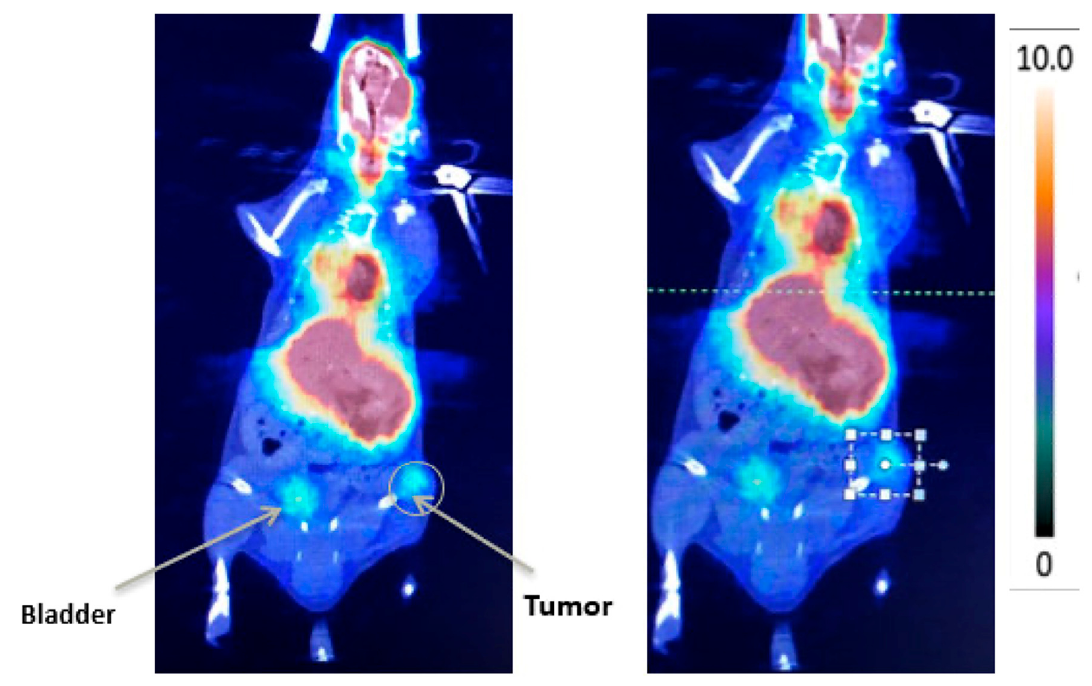
Figure 1. 68Ga-PSMA PET / CT images showing tumor recurrence.